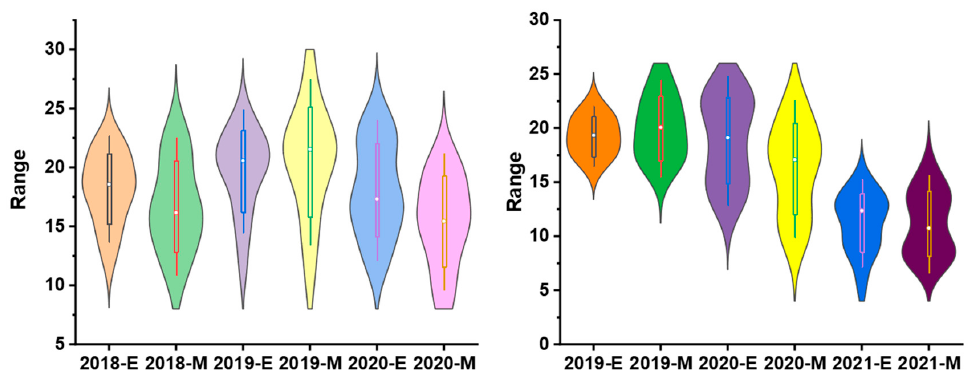
Figure 4. Distribution of the estimated and measured sucrose yield of 14 sugarcane cultivars from estimated sucrose yield, while 2018-M, 2019-M, 2020-M and 2021-M represent the measured sucrose yield in the field.